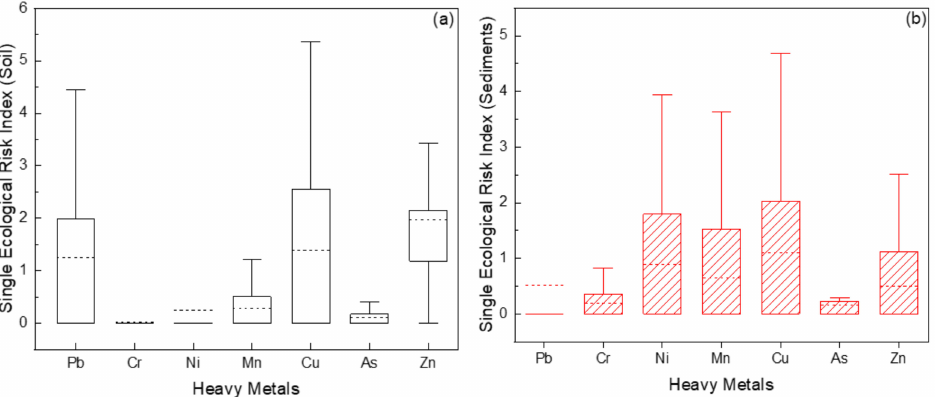
Figure 4. ( a ) Boxplot of single ecological risk index of Pb, Cr, Ni, Mn, Cu, As, and Zn for soil; ( b ) Boxplot of single ecological risk index of Pb, Cr, Ni, Mn, Cu, As, and Zn for